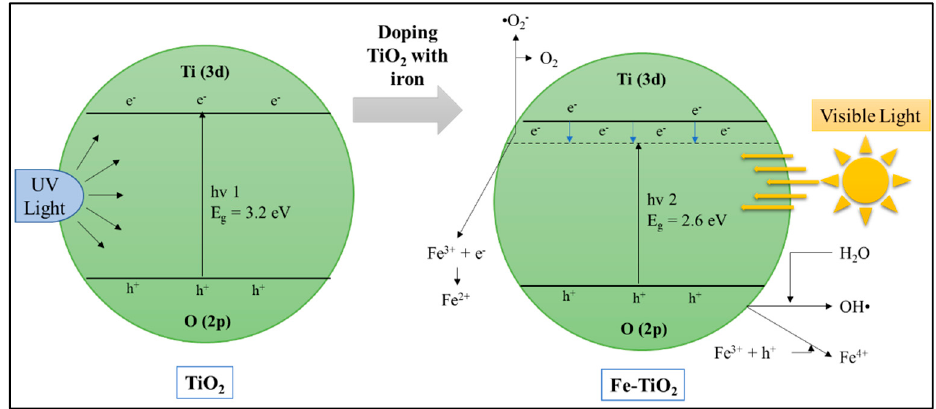
Figure 16. The schematic energy level of undoped TiO 2 and iron-doped TiO 2 (Fe-TiO 2 ) Anion Dopants